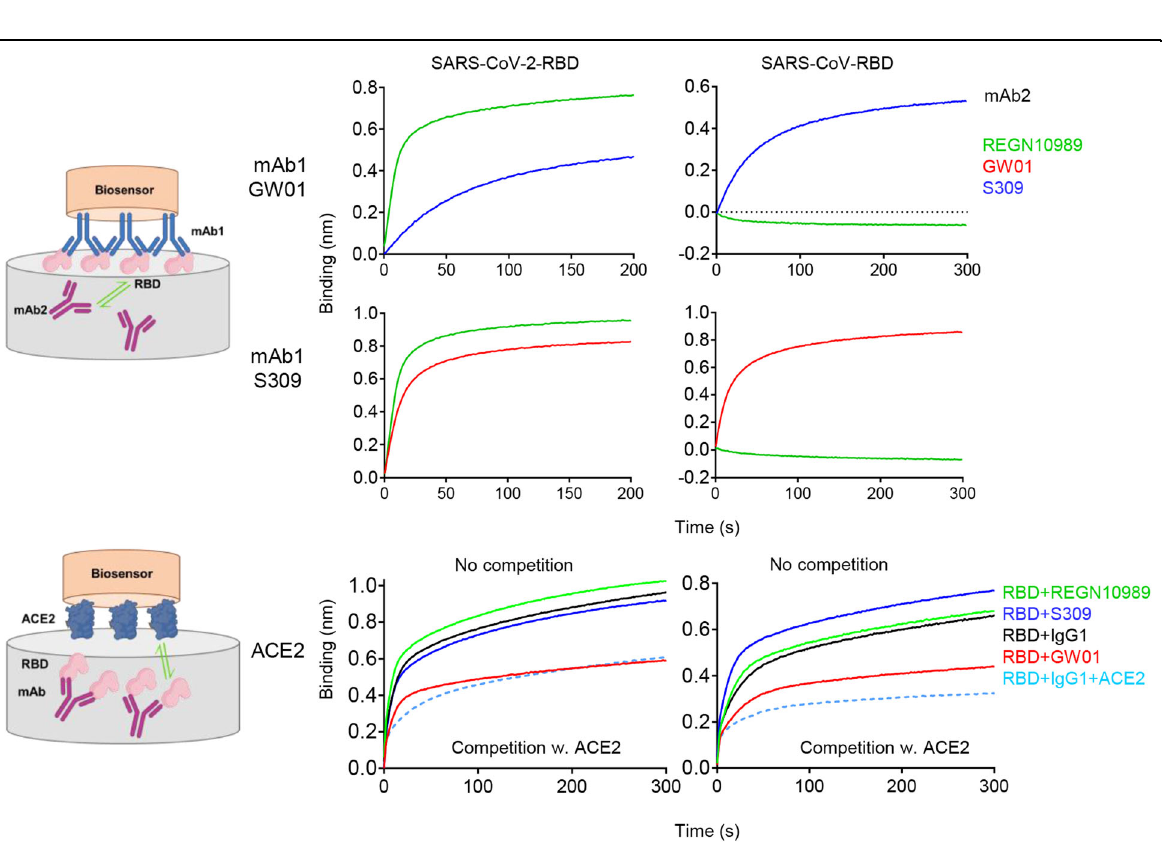
Fig. 2 GW01 binds to an RBD epitope distinct from that of REGN10989 and overlaps with the ACE2-binding site. a Binding of GW01 to SARS- CoV-2 RBD (left) and SARS-CoV RBD (right) in competition with S309 and REGN10989 as measured by bilayer interferometry experiments. S309 was used as a control. b Binding of ACE2 to SARS-CoV-2 RBD (left) and SARS-CoV RBD (right) in competition with GW01 (red), S309 (blue), REGN10989 (green), control IgG1, and